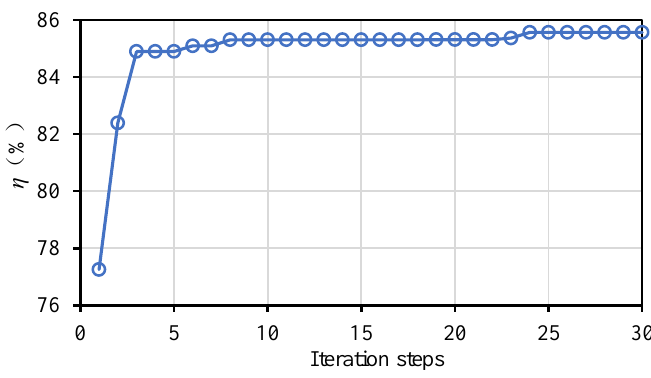
Figure 16. Efficiency change process in the optimization process.